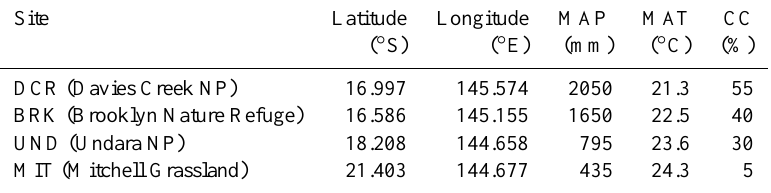
Table 1. Characteristics of the studied sites.